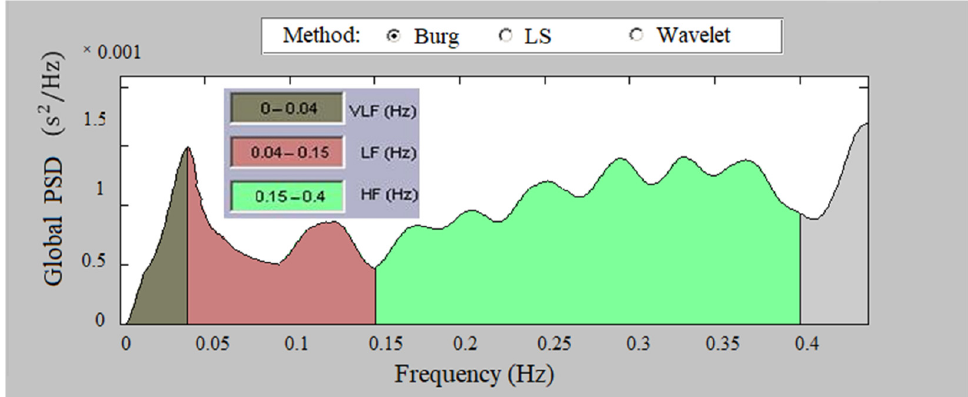
Figure 9. Global PSD of a healthy individual, Burg method.